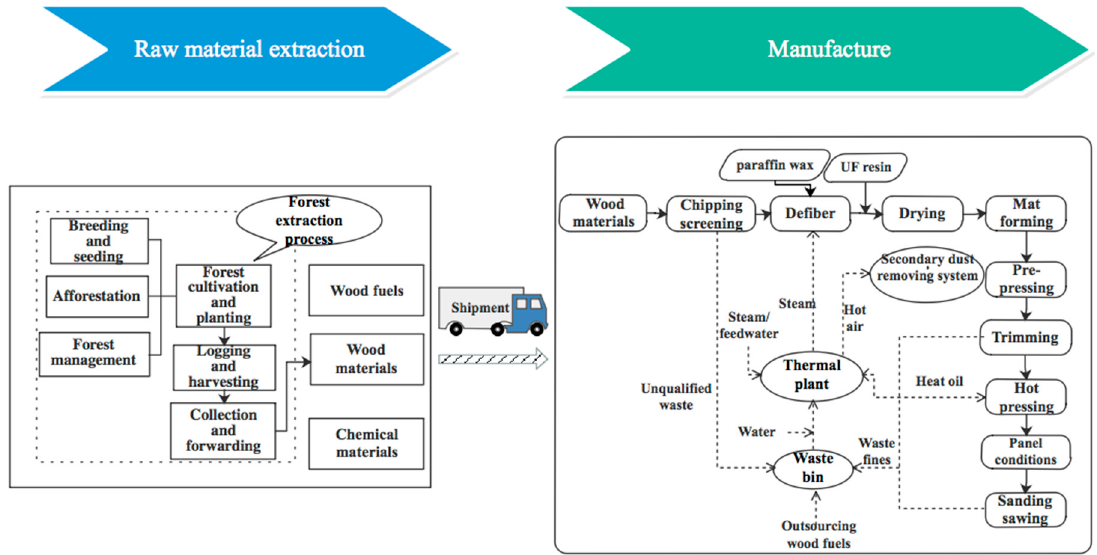
Figure 1. Cradle-to-gate system boundary of medium-density fiberboard (MDF) production in China.